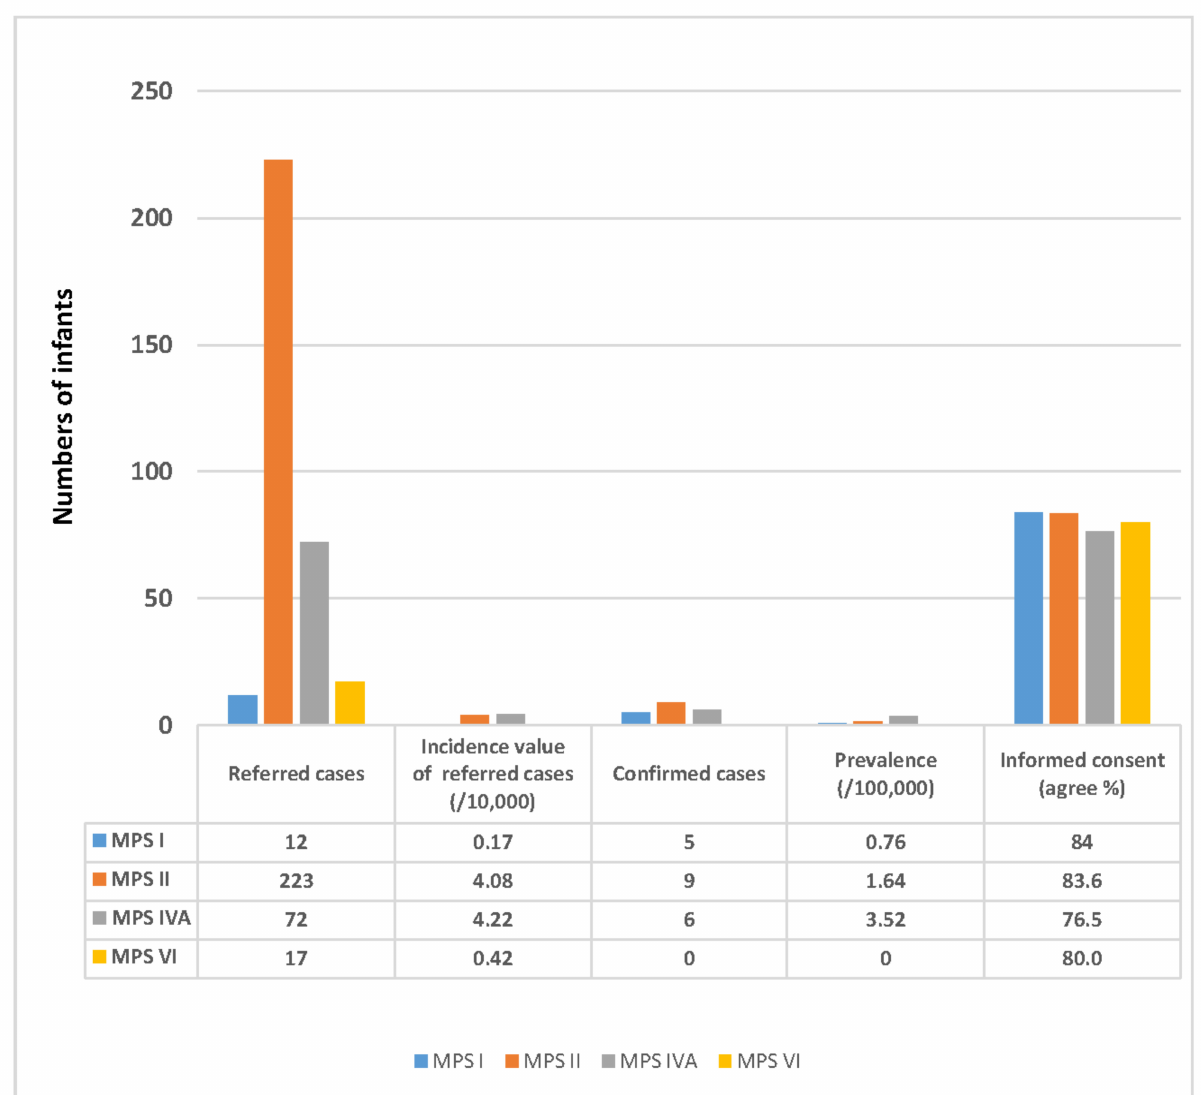
Figure 1. The number of infants referred for each type of MPS from the newborn screening program and the prevalence of each type of MPS.The first column is the number of referred cases; the second column shows the incidence (/10,000) of referred cases; the third column shows the number of confirmed MPS cases by MPS type; the four column shows the prevalence of individual MPS types; and the fifth column shows the percentages of the guardians who signed inform consent by MPS